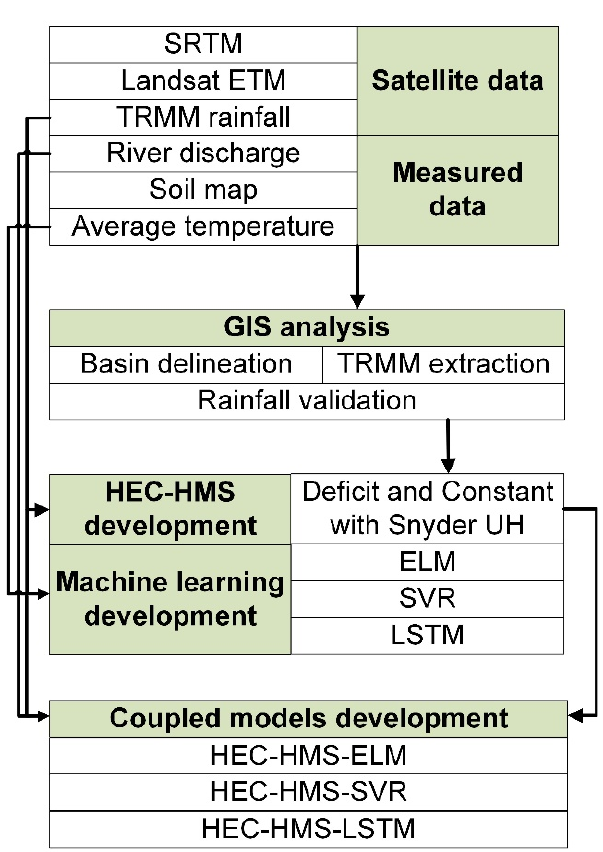
Figure 4. Flowchart of the developed coupled models, SRTM: shuttle radar topography mission.